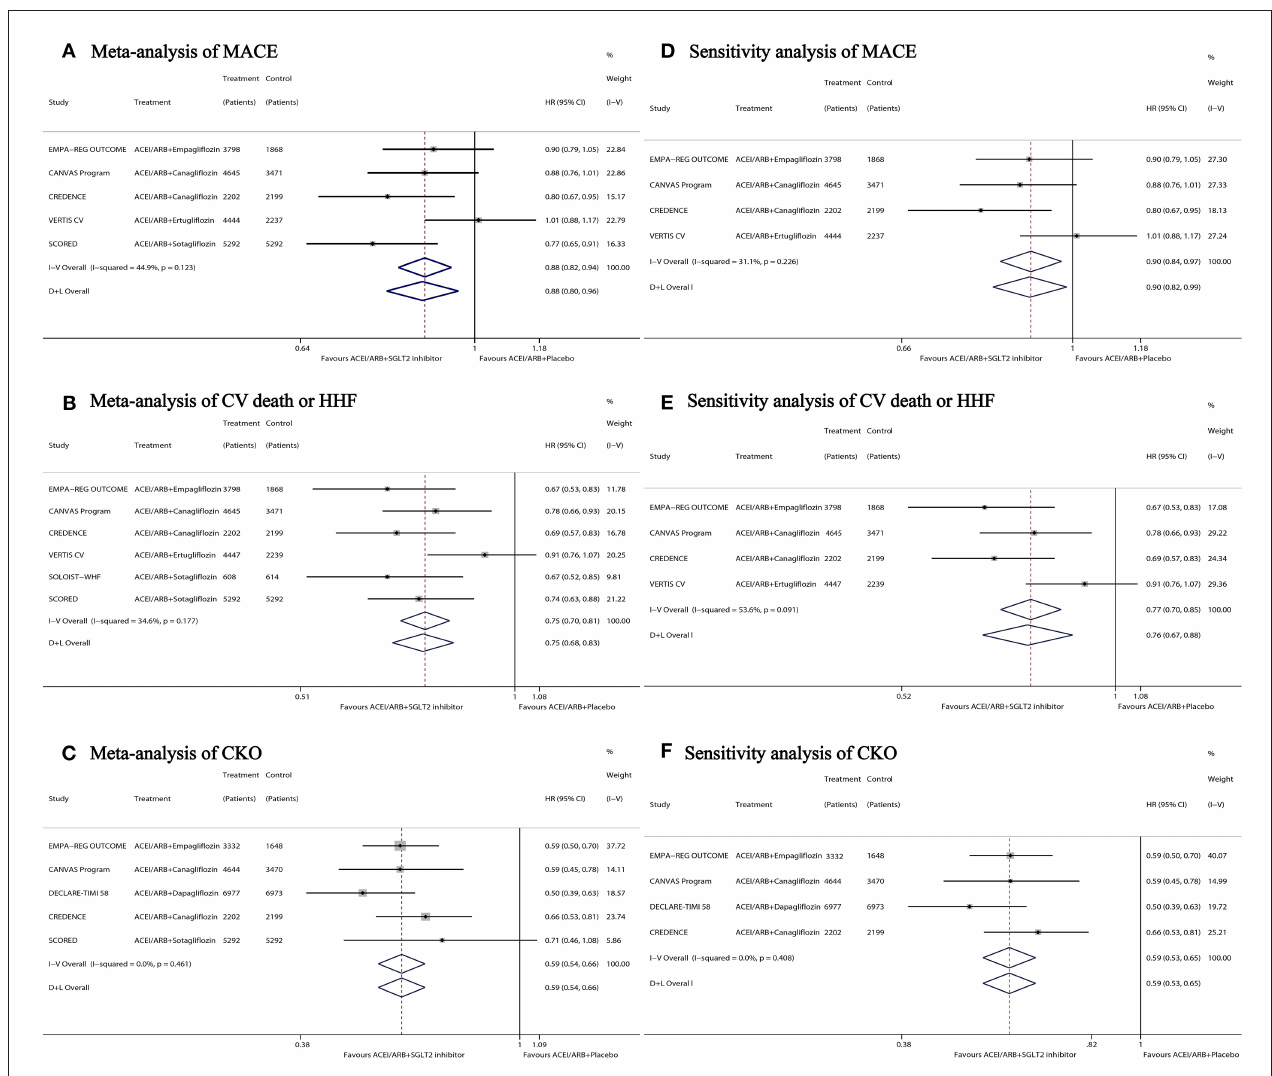
FIGURE 1 | Meta-analysis (A – C) and sensitivity analysis (D – F) of ACEI/ARB + SGLT2 inhibitor vs. ACEI/ARB + placebo on MACE, CV death or HHF, and CKO. ACEI, angiotensin-converting enzyme inhibitors; ARB, angiotensin receptor blockers; SGLT2, sodium-glucose transporter 2; MACE, major adverse cardiovascular events; CV death or HHF, cardiovascular death or hospitalization for heart failure; CKO, composite kidney outcome; HR, hazard ratio; CI, confidence